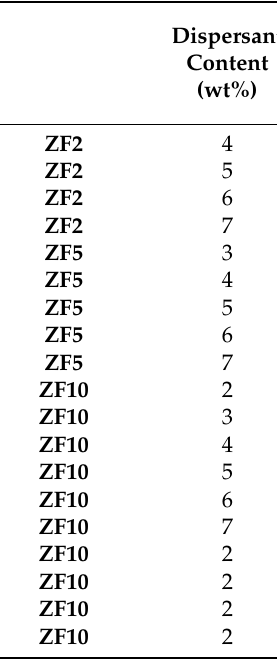
Table 5. Fitting data